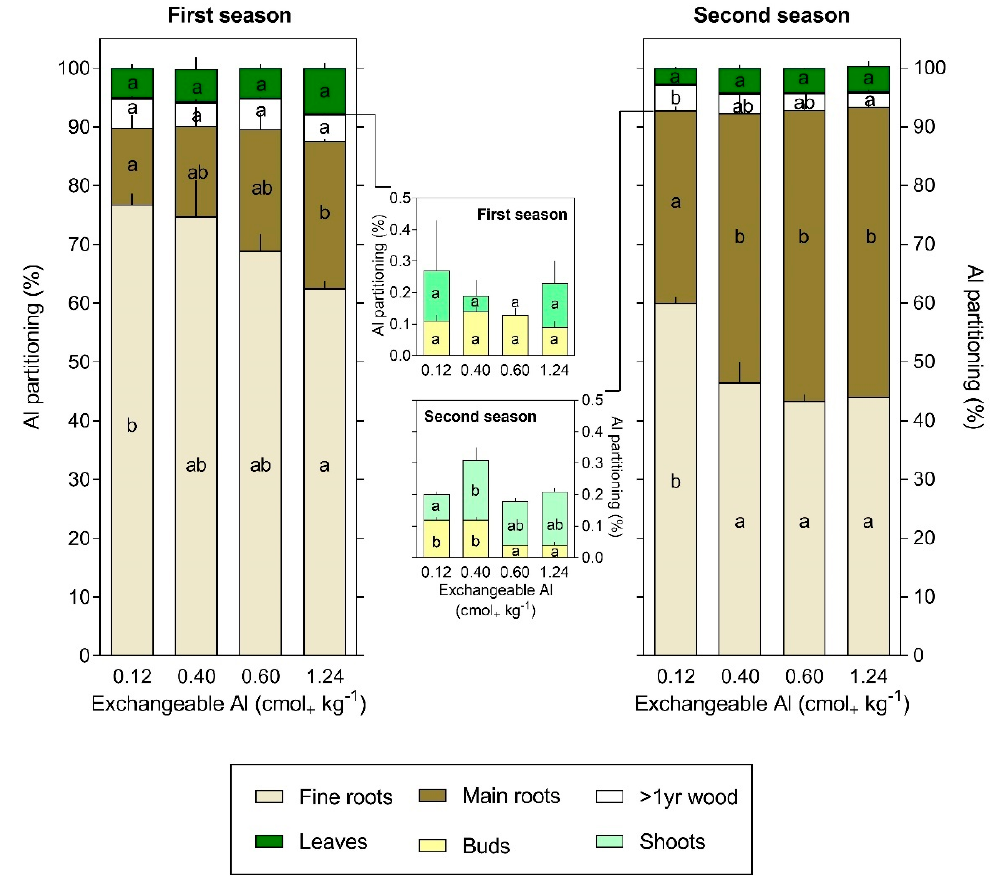
Figure 6. Al partitioning in individual organs of sweet cherry trees growing with increasing con- centrations of exchangeable Al in a volcanic soil. The vertical bars represent standard errors ( n = 3). Different small letters in the same organ indicate significant differences between treatments (Tukey’s test; p < 0.05).